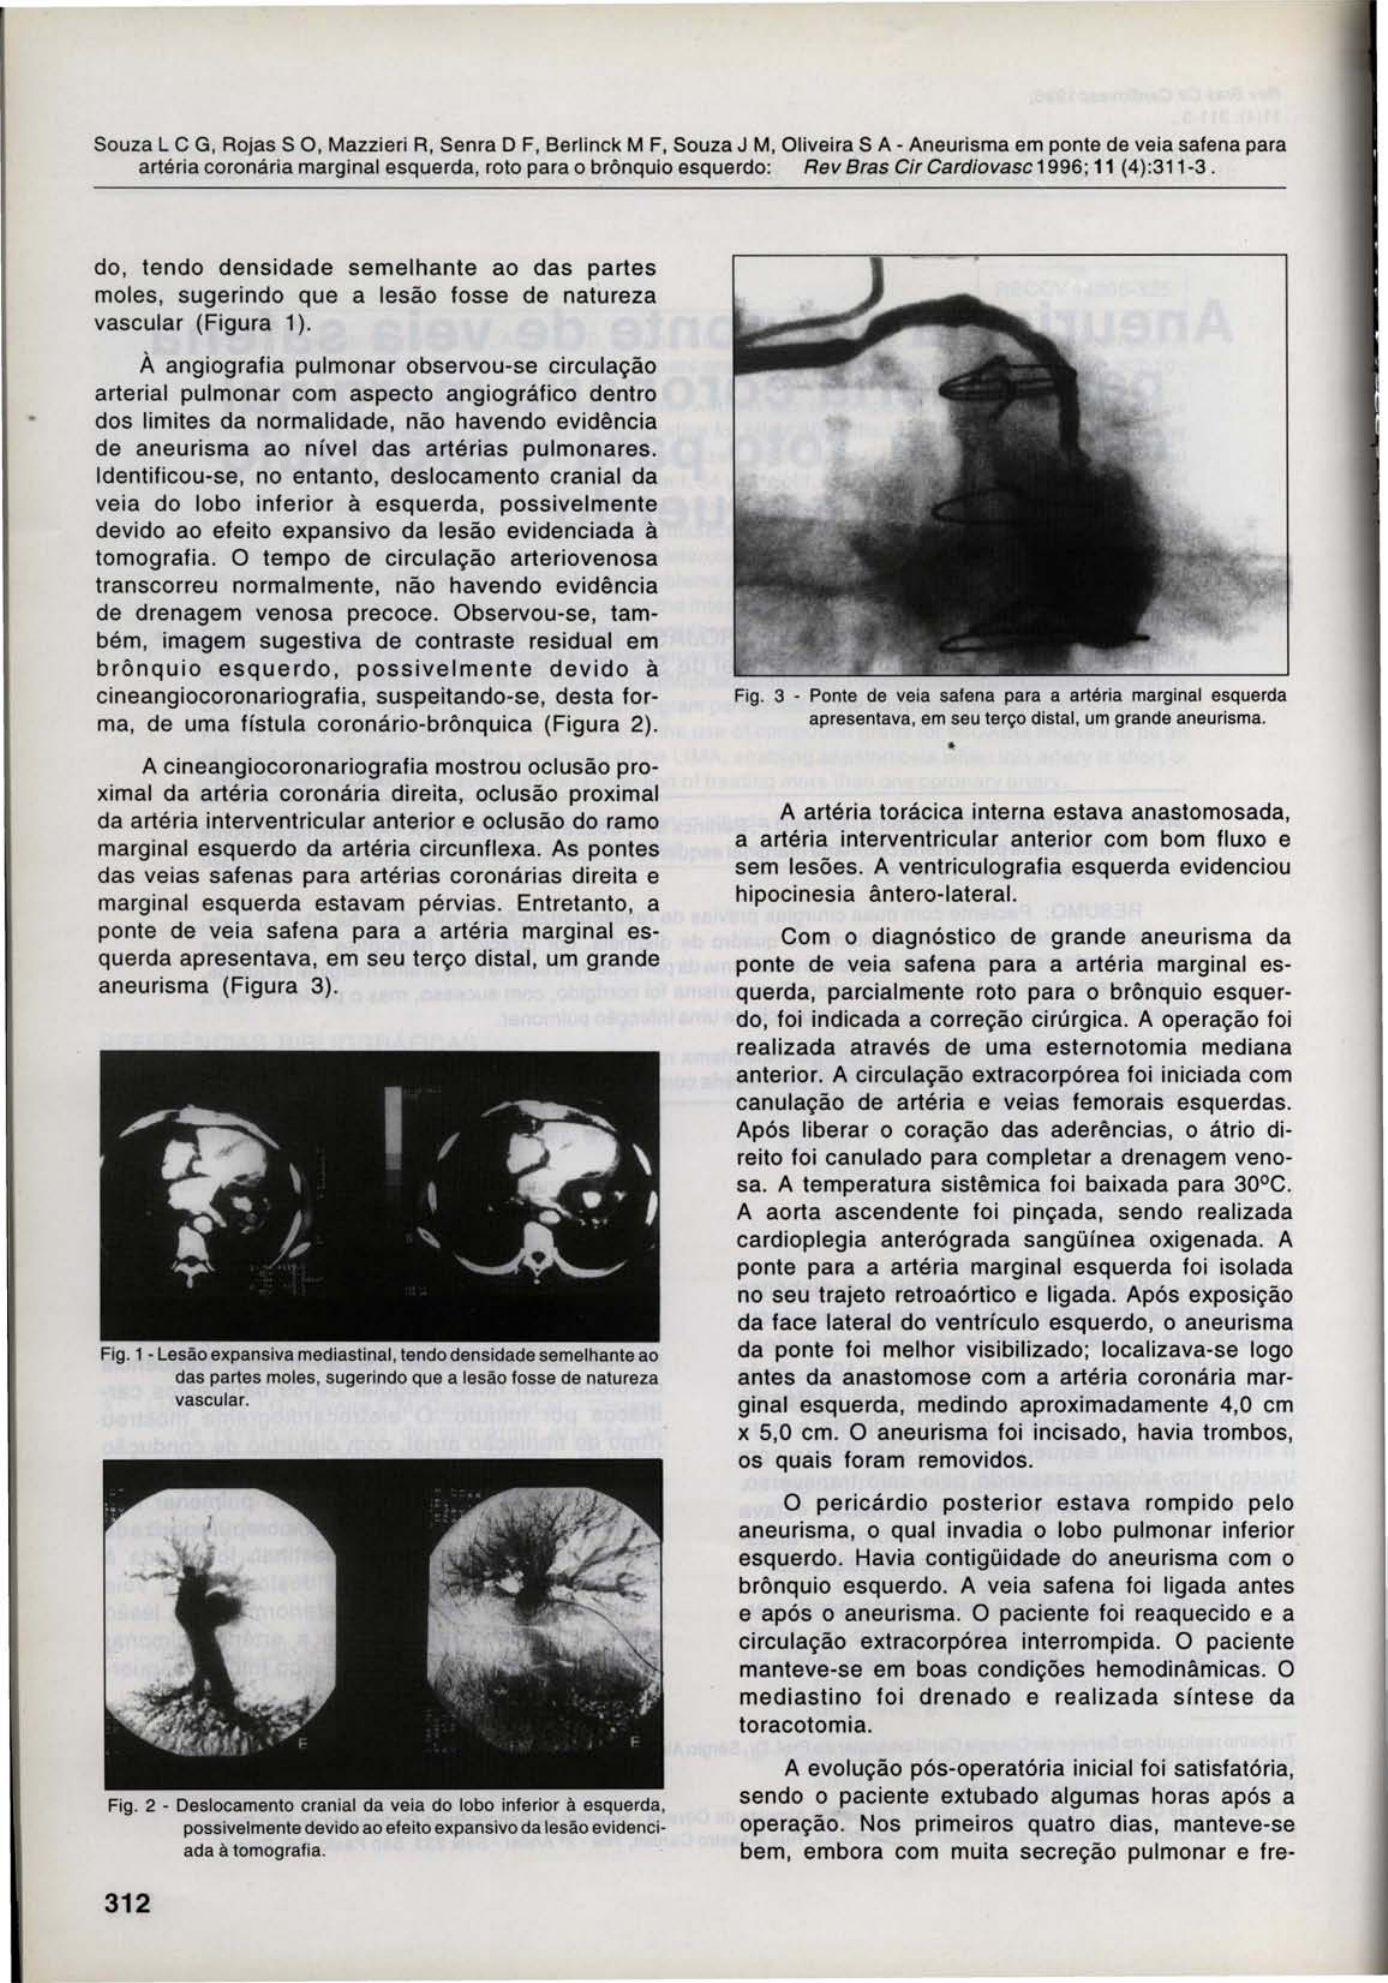
Fig. l -Lesão expansiva mediastinal, tendo densidade semelhante ao das partes moles, sugerindo que a lesão fosse de natureza vascular.